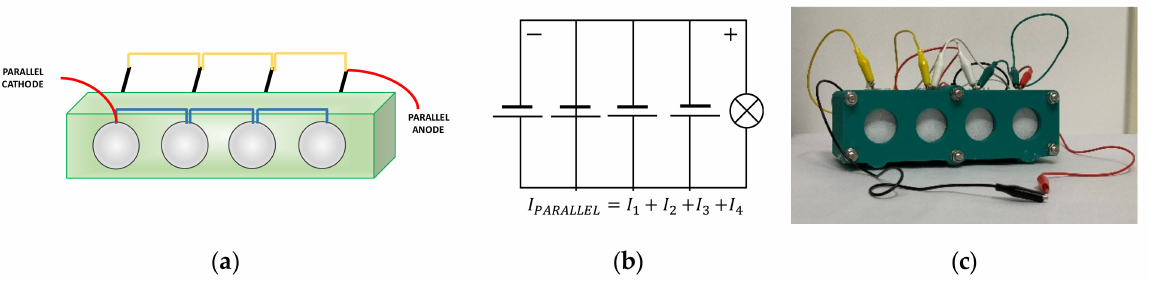
Figure 8. Multi-electrode MFC configuration: ( a ) scheme, ( b ) electrical connection mode and ( c ) multi-electrode MFC tested in